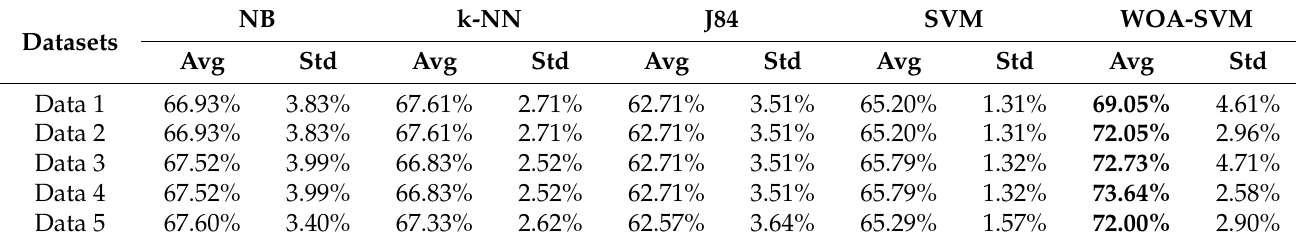
Table 4. Accuracy results of standard classifiers against WOA-SVM for First-rules datasets.